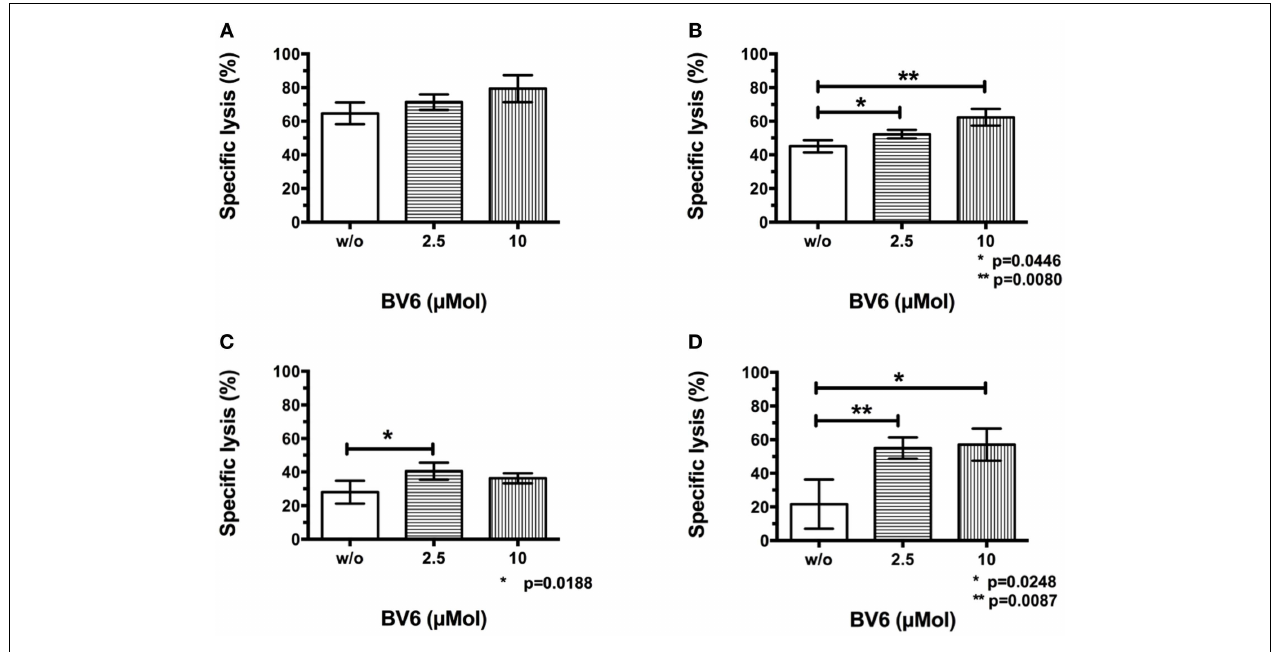
measurements were performed after extending BV6 sensitization period from 4 to 12h to increase CIK cell-mediated cytotoxicity towards more resistant target cells like RH30 (C) andTE671 cell lines (D) . Cytotoxicity results showed that CIK cell-mediated killing of RH30 andTE671 cell lines was significantly but dose-independently increased, but there was no further enhancement compared to four-hour per-incubation of target cells with BV6.